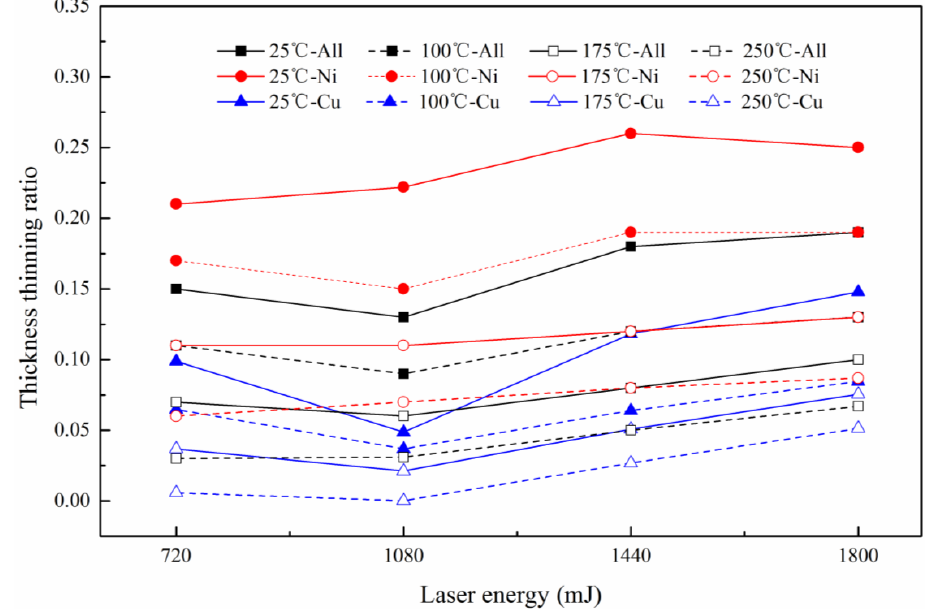
Figure 15. The thinning ratio distribution of copper, nickel and composite layer.